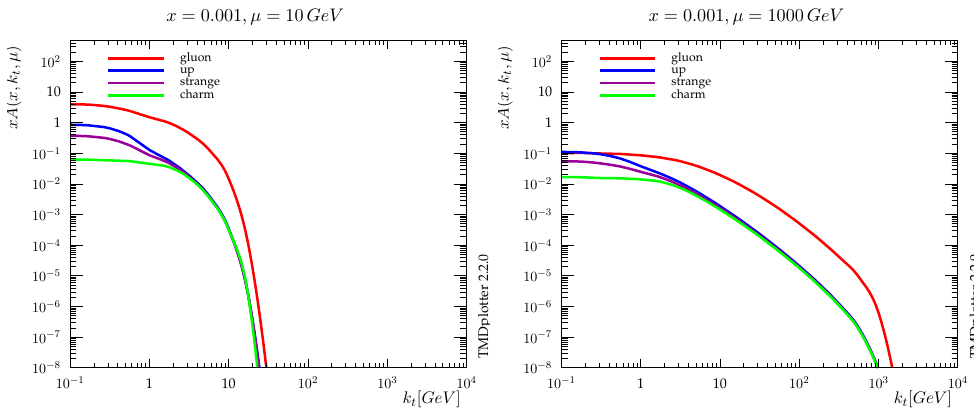
Figure 8 . Transverse momentum distributions at x = 0 : 001 and evolution scales (cid:22) = 10 GeV (left), (cid:22) = 1000 GeV (right) for di(cid:11)erent (cid:13)avors. exact parton-splitting kinematics in the region of strongly ordered momentum fractions z 1. The results in (cid:12)gures 6 and 7 imply that this approximation will not be valid for (cid:28) observables sensitive to the detailed structure in transverse momentum of the initial